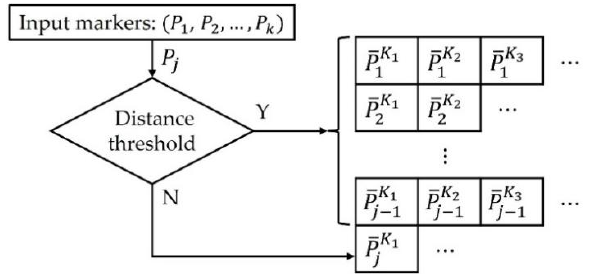
(cid:3012) (cid:3286) is an average of 𝑗 - (cid:3037)